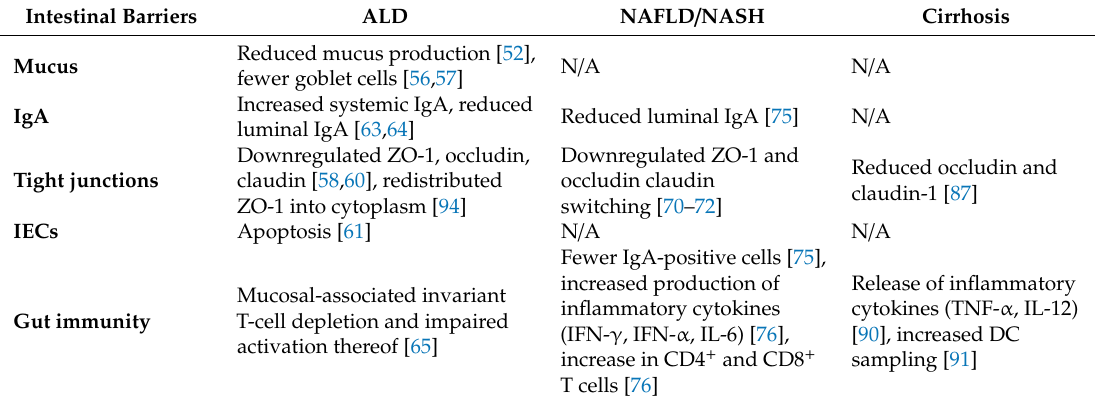
Table 1. Intestinal barrier deficiencies in chronic liver